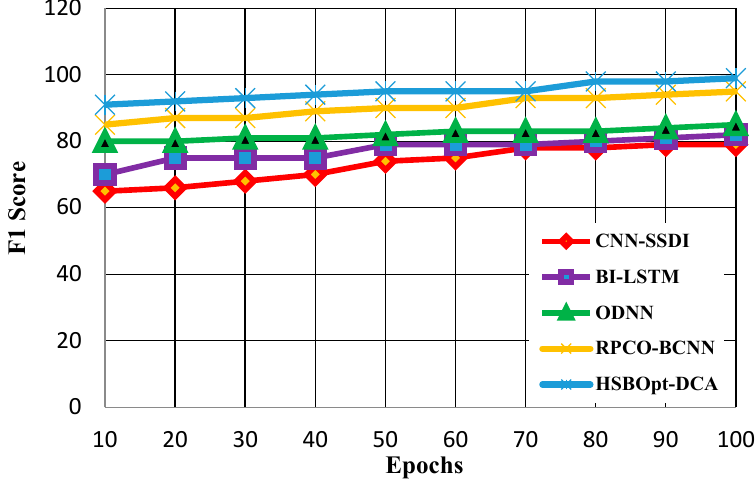
Figure 10. F1-score calculation with 100 epochs.